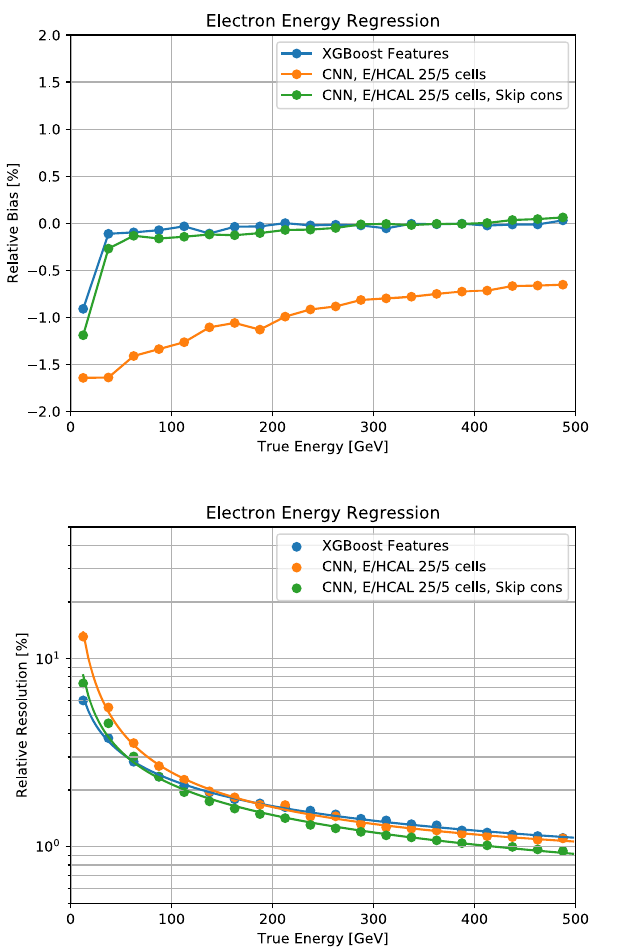
I Energy regression at fixed